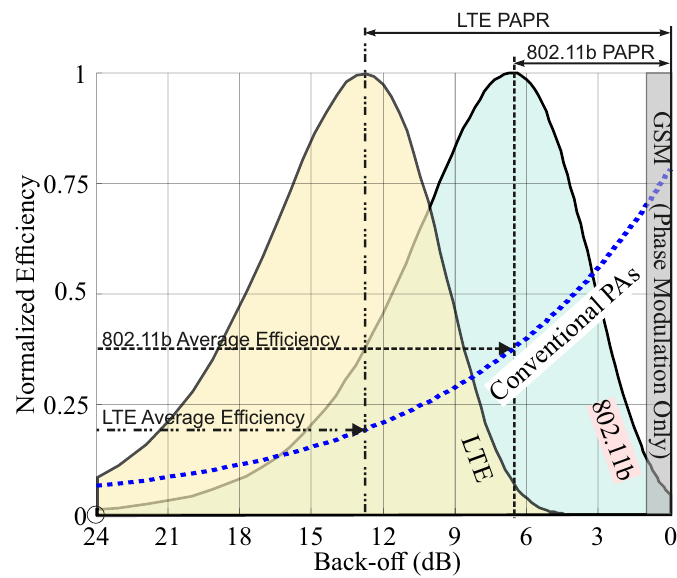
Figure 2. Efficiency of a Class-AB Power Amplifier (PA) compared to the probability density function of modern modulated signals.